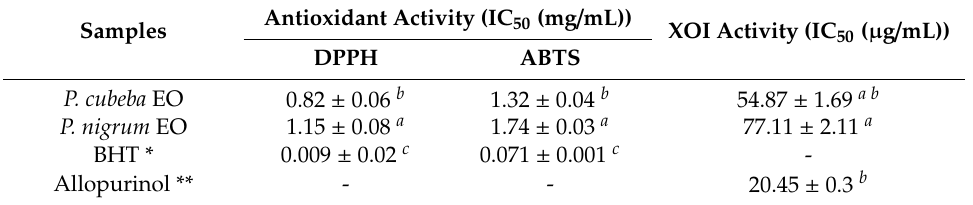
Table 1. Antioxidant and xanthine oxidase inhibitory activities of EOs from P. cubeba and P. nigrum . Samples